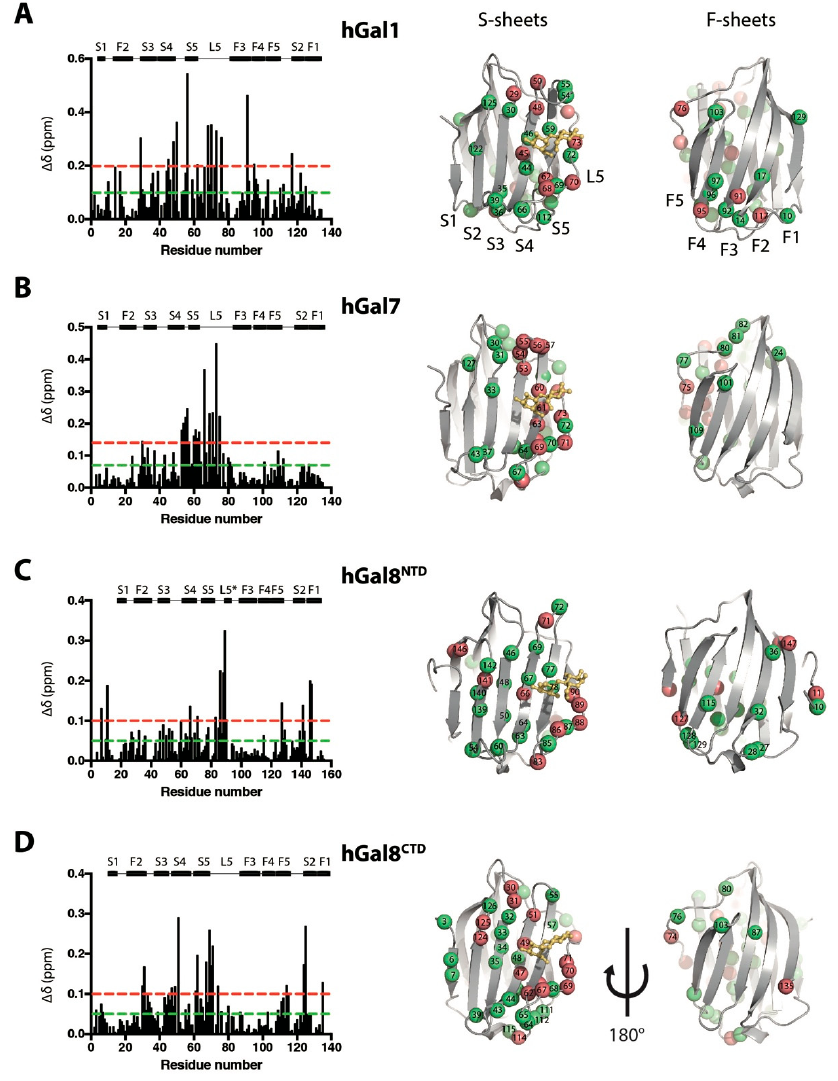
Figure 4. Structural mapping of lactose binding-induced CSPs in hGal1, hGal7, hGal8 NTD , and hGal8 CTD . Weighted CSPs upon lactose binding were plotted as a function of residue number (left panels) for ( A ) hGal1, ( B ) hGal7, ( C ) hGal8 NTD , and ( D ) hGal8 CTD . The values of 1 σ and 2 σ are shown by green and red dashed lines, respectively. The residues that exhibited CSPs greater than 1 σ but less than 2 σ (green spheres) and greater than 2 σ (red spheres) are indicated on the corresponding crystal structures shown in the right panels. Crystal structure of hGal8 NTD shows a short β -sheet in L5 indicated by L5*.